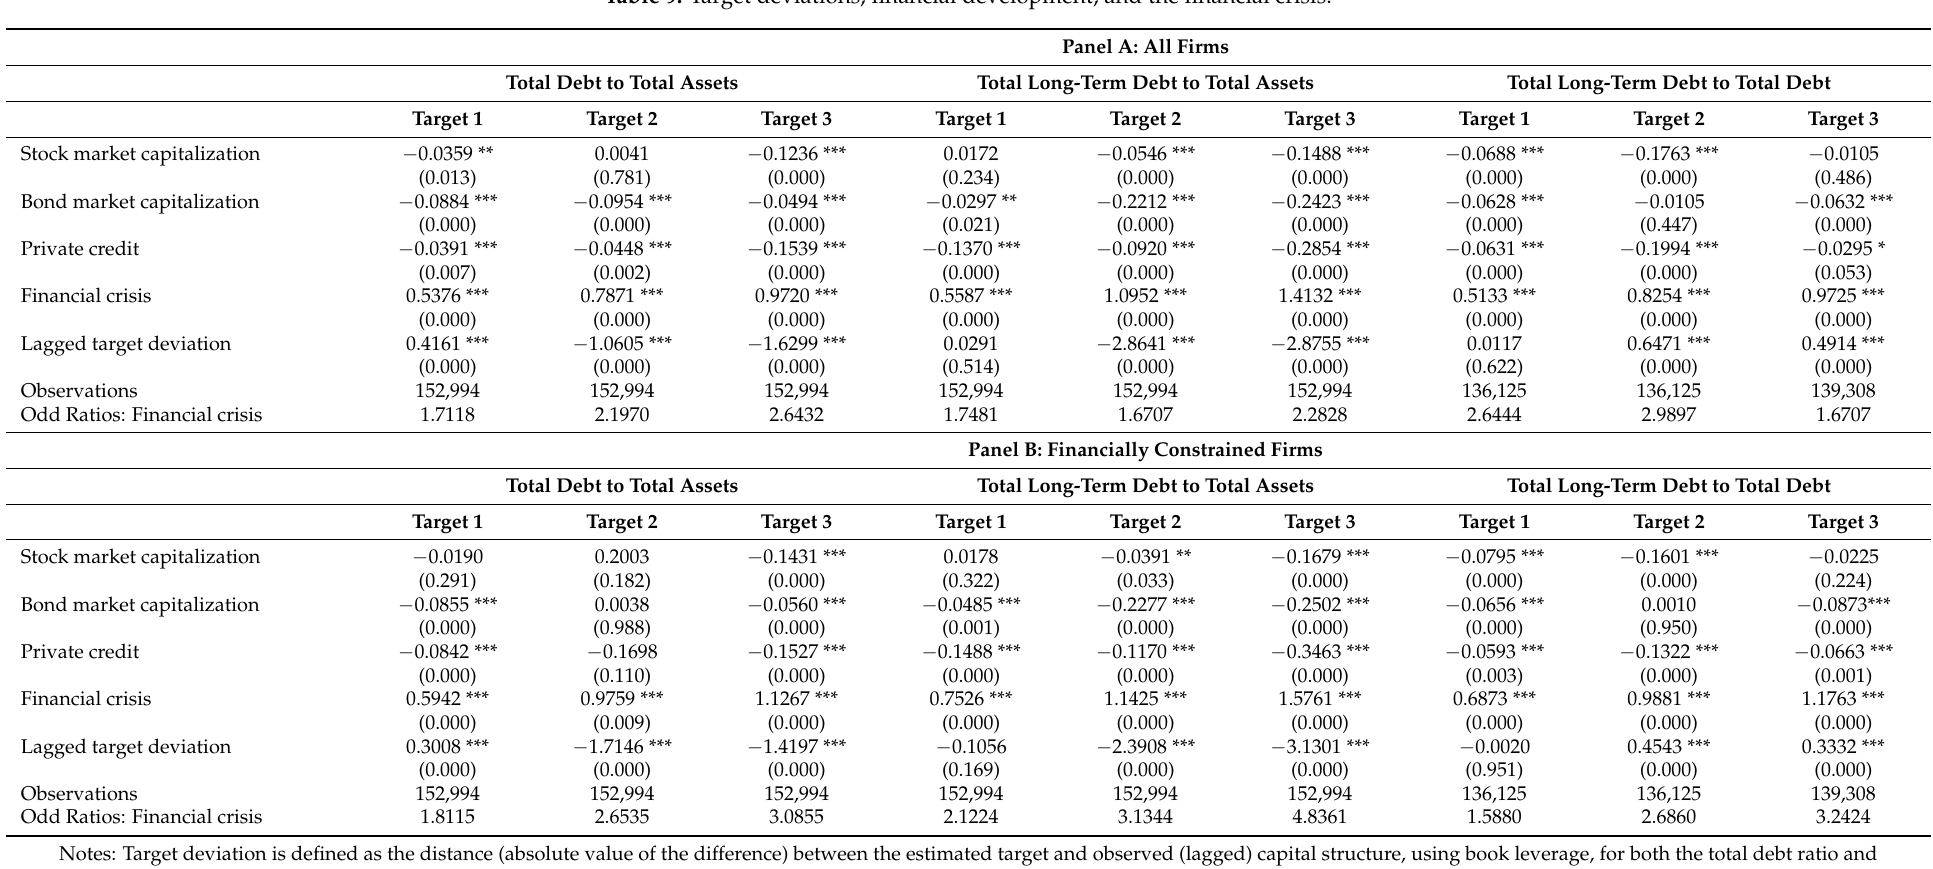
Table 9. Target deviations, financial development, and the financial